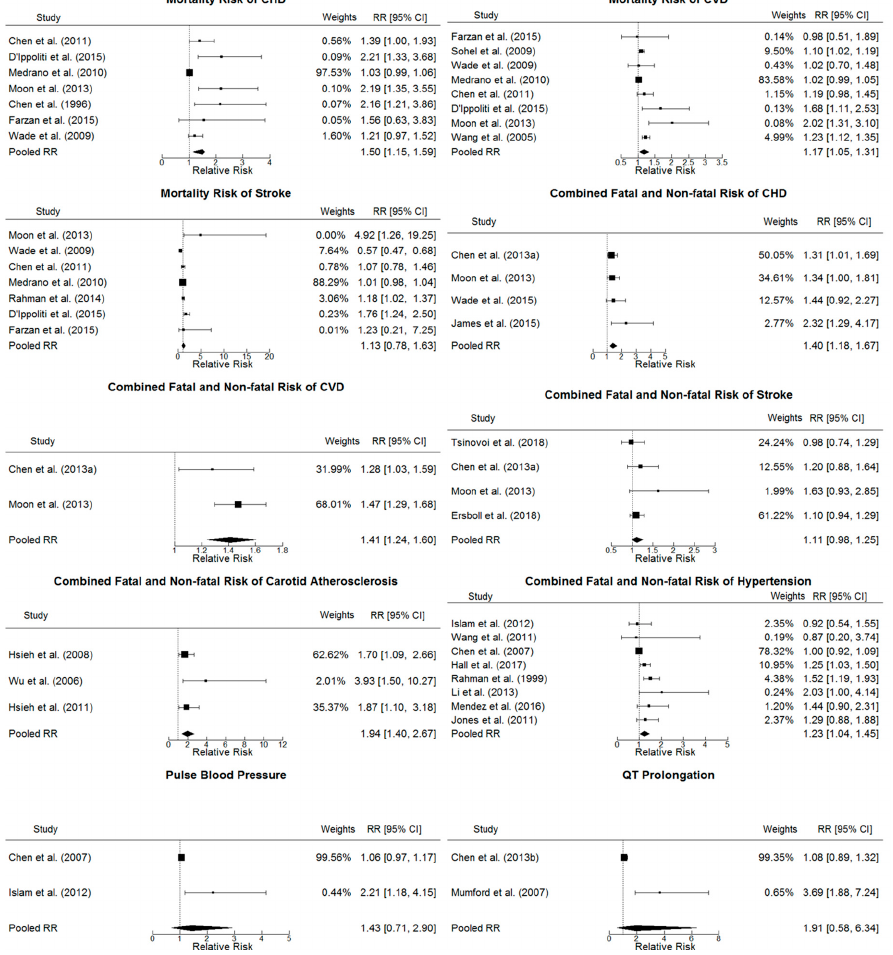
Figure 3. Forest plot of individual study and pooled log-linear relative risks (95% confidence intervals (CIs)) of different CVD endpoints, comparing 10 µg/L with 1 µg/L drinking water arsenic concentration. The sizes of squares of the individual study relative risks were weighted by the inverse